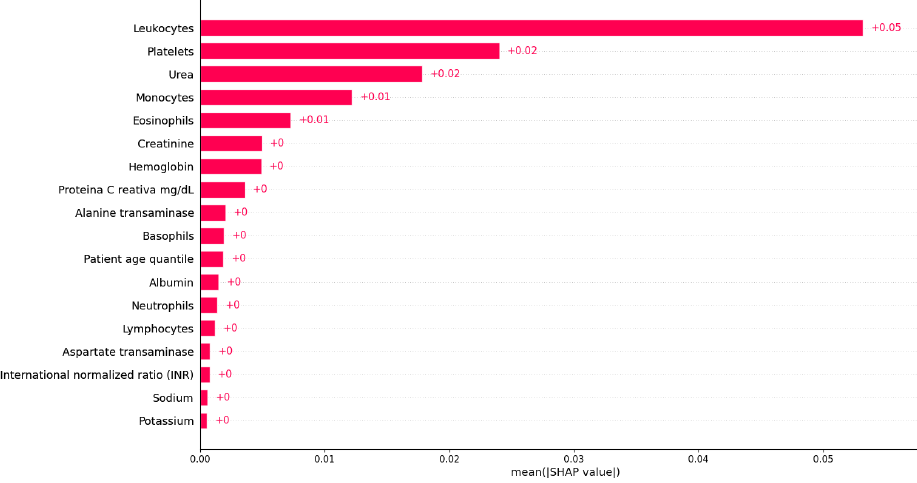
Figure 8. Feature importance identification using XGBoost based on Dataset